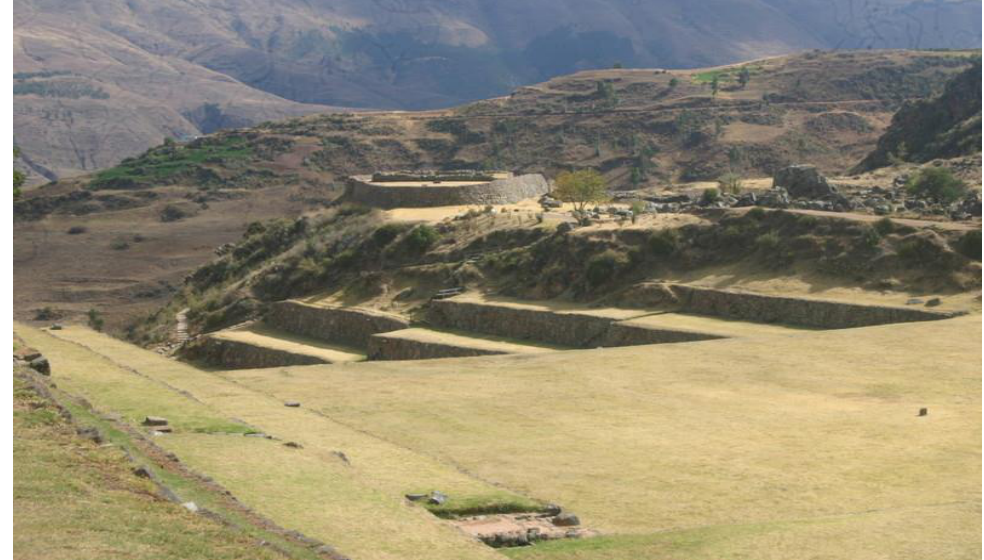
Figure 3. View of the walled Sinkunakancha ceremonial plaza location shown in Figure 1 with water supply from a lower branch channel from the Main Canal and a leftmost channel from the northern Pukara area from Rio Pukara. (Photo by C.